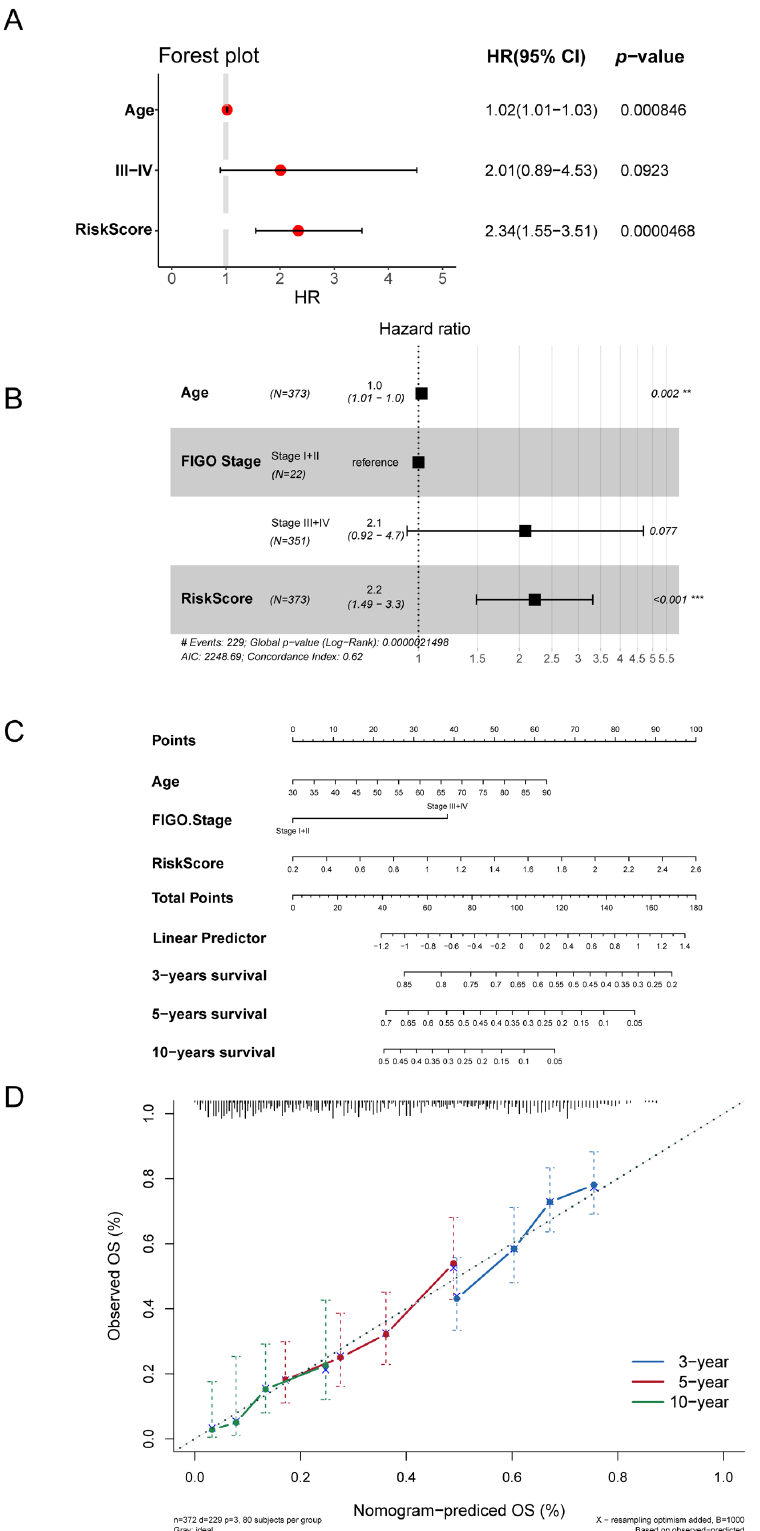
Figure 6. Assessment of the prognostic value of autophagy-related signature: Univariate ( A ) and multivariate ( B ) Cox regression analyses of age, FIGO stage and autophagy risk score in the TCGA cohort. ( C ) A nomogram integrating the autophagy-related signature risk score with the clinical char- acteristics to quantify risk evaluation for each patient. ( D ) The calibration curves for the nomogram in the OC cohorts from